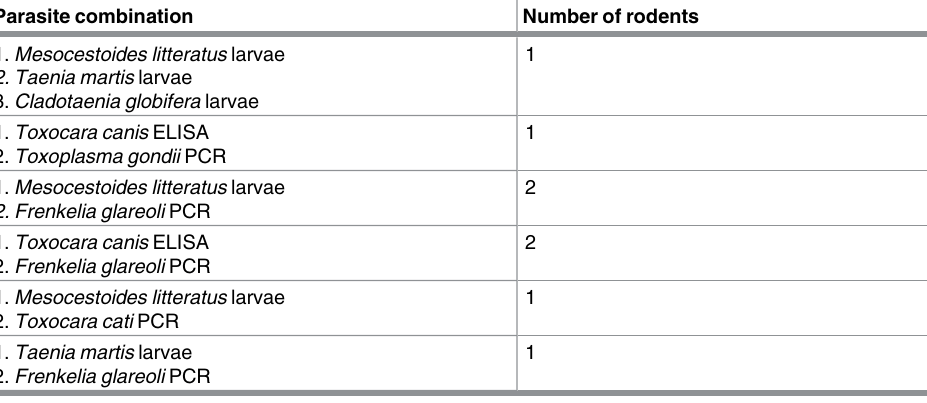
Table 4. Parasiteco-infections found in examined mice (n =